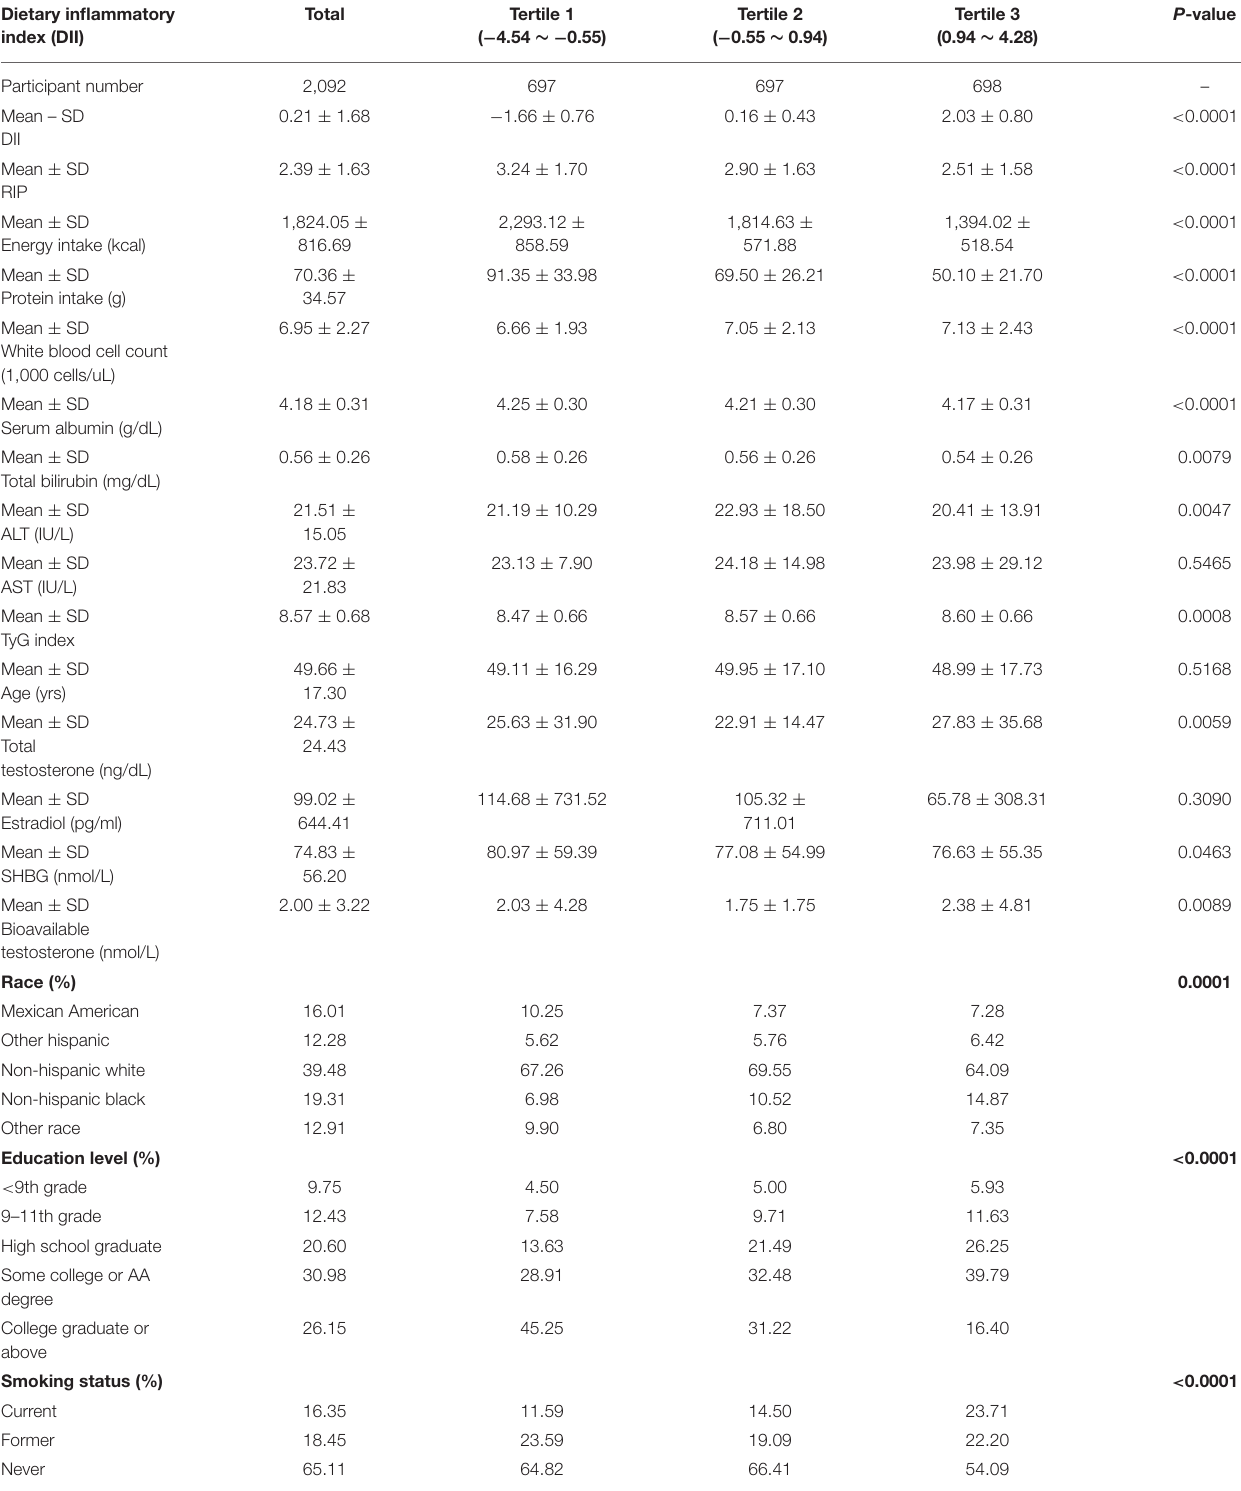
TABLE 1 | Baseline characteristics of participants from 2013 to 2016 NHANES, weighted. Dietary inflammatory index